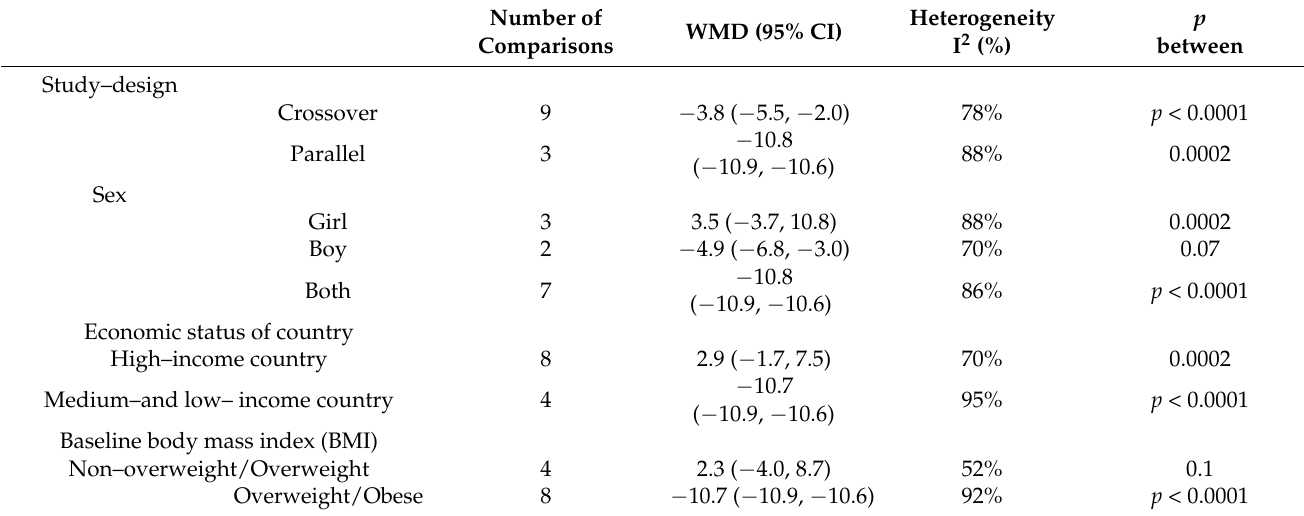
Table 7. Results of subgroup–analysis for hunger (mm) an d protein–rich breakfast (pre-lunch). Number